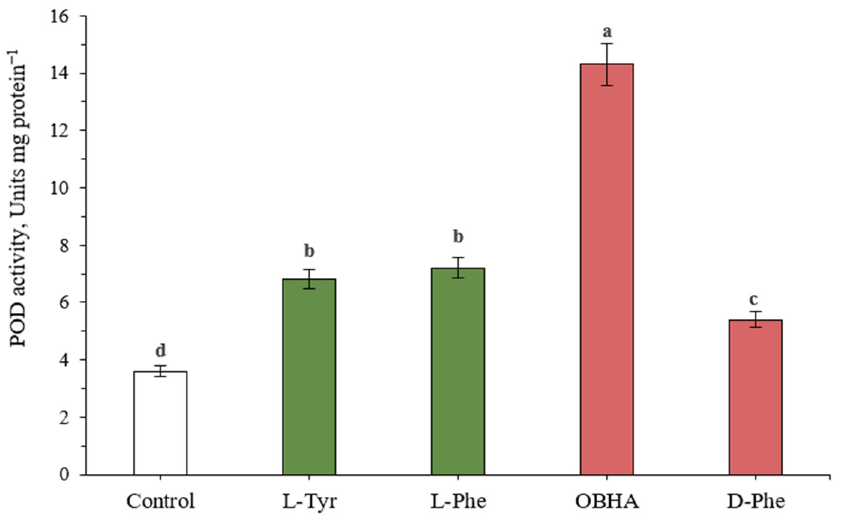
Figure 2. POD activity in wheat samples incubated on a nutrient medium supplemented with 500 µ M of active compounds. Bars marked with different letters show the significant differences at ( p ≤ 0.05) according to Tukey’s test.